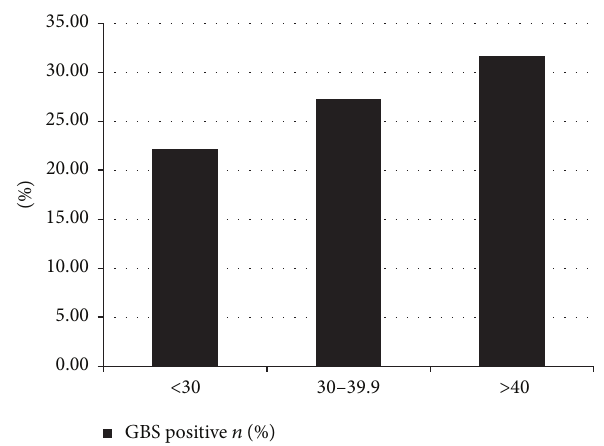
Figure 2: Risk of GBS colonization with increasing obesity cate-